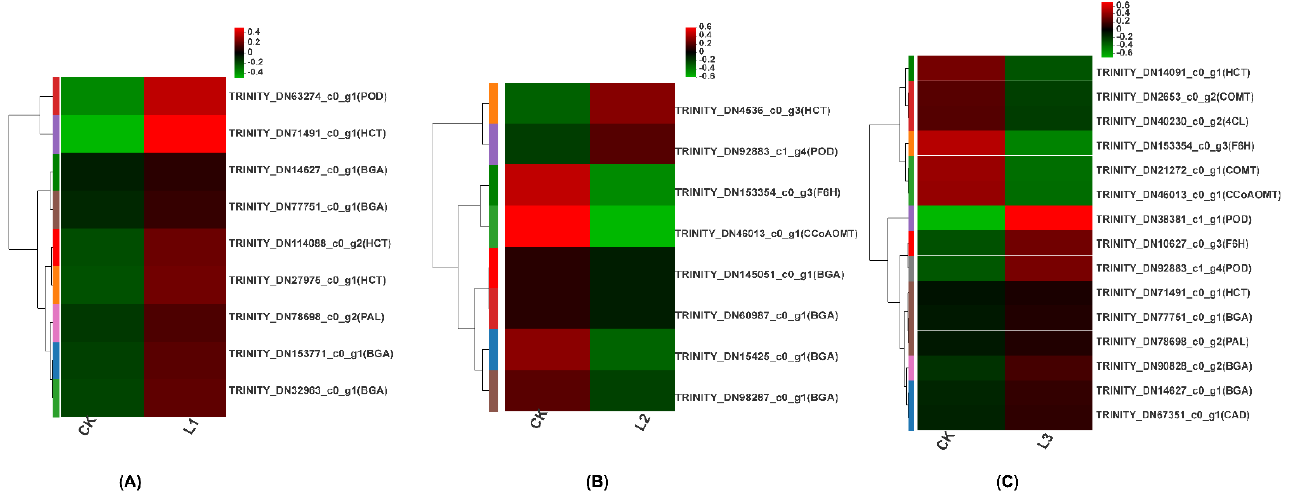
Figure 7. Heat map of differential expression of the genes in the coumarin biosynthesis pathway under different light intensities. ( A ) CK vs. L1; ( B ) CK vs. L2; ( C ) CK vs. L3. Red and green colors correspond to high and low expression levels, respectively.